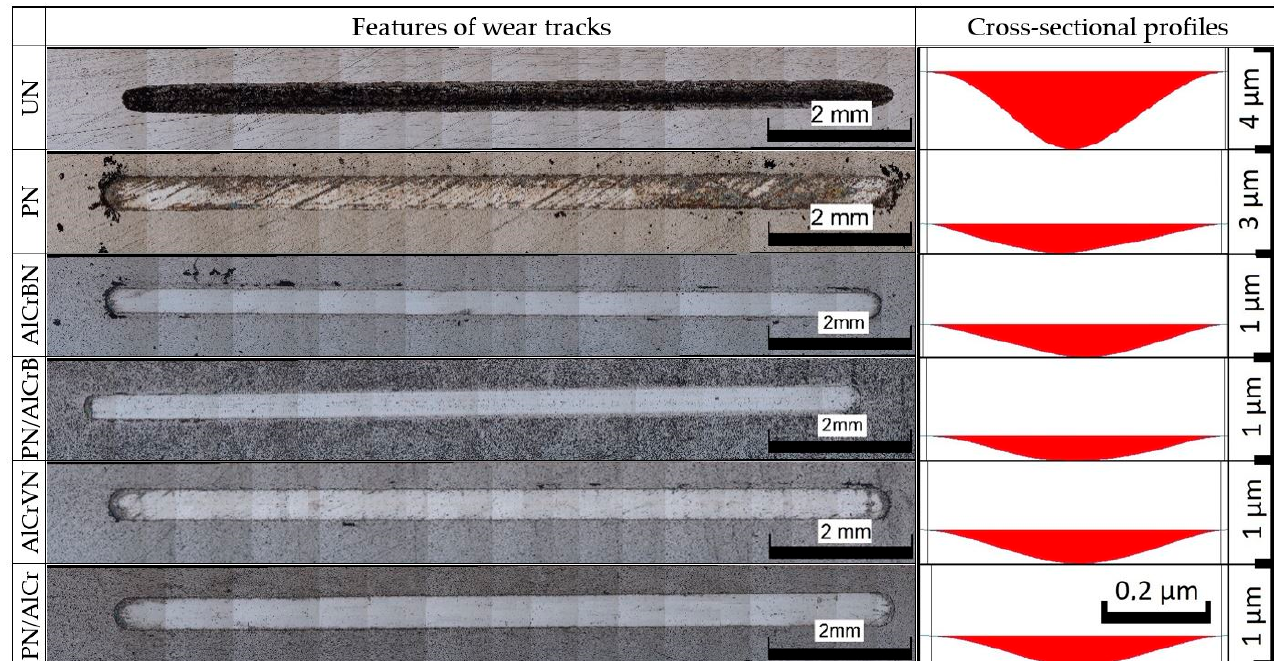
Figure 14. Features and cross-sectional of wear tracks of tested materials steel H13.